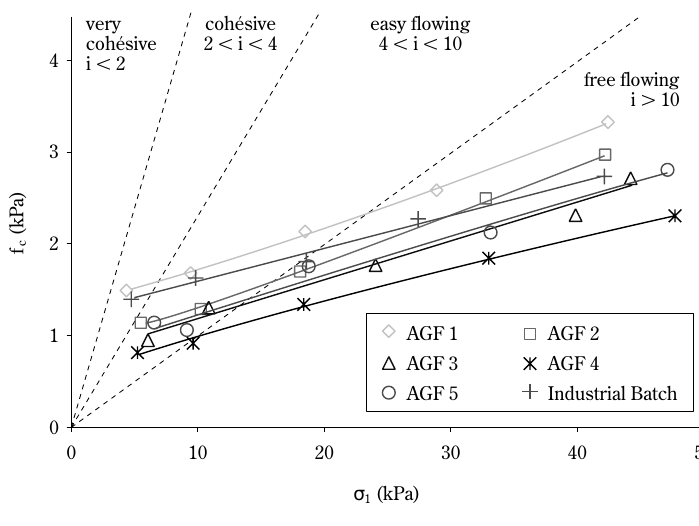
Fig. 12 Flow function and classification according to the flowability index (i)